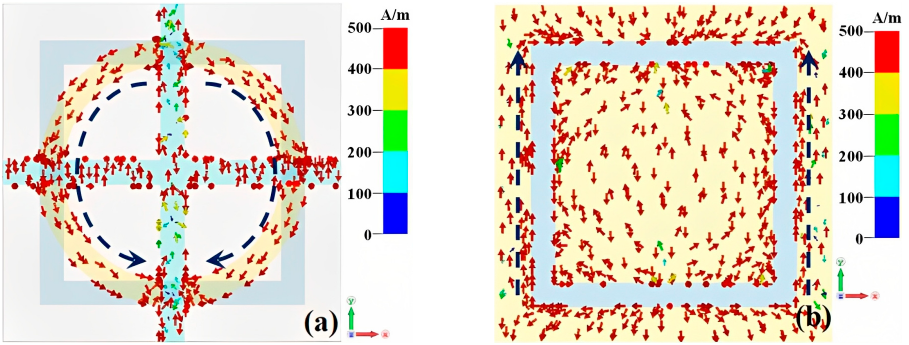
Figure 5. The equivalent impedance of the metamaterial absorber when the conductivity of VO 2 is 10 S/m.